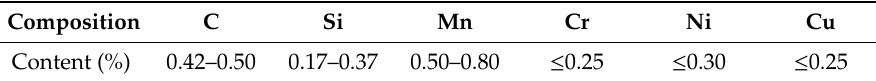
Table 1. Composition of 45 steel.